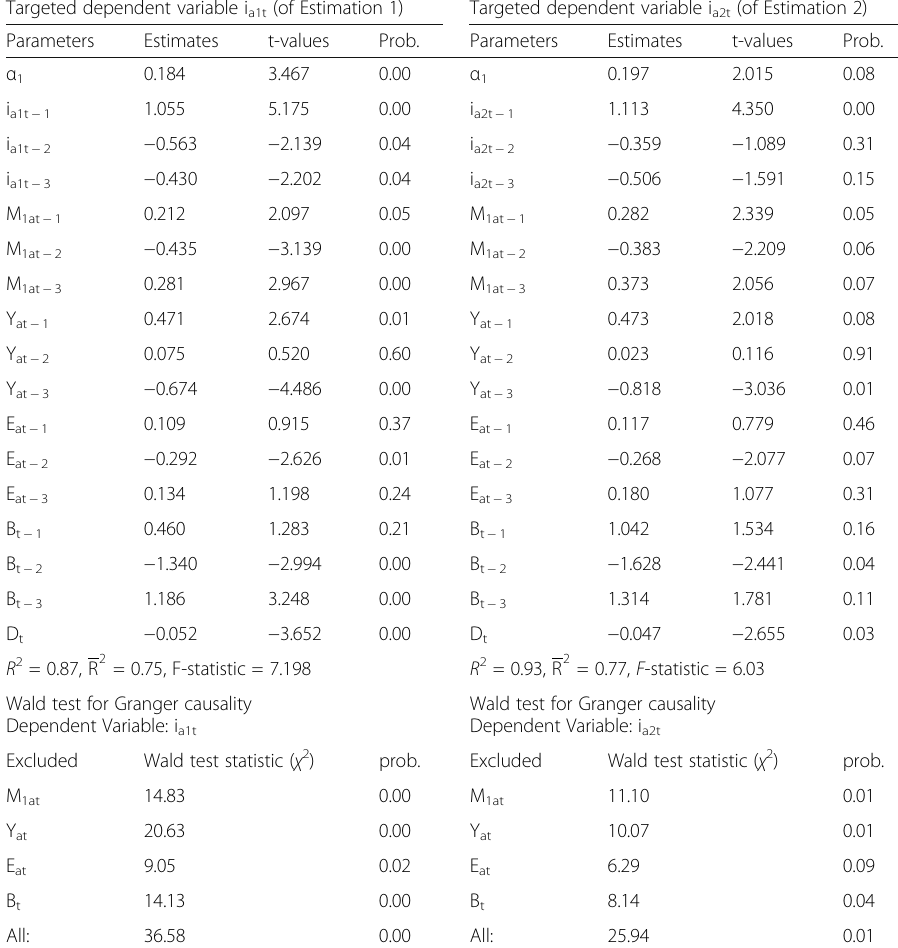
Table 3 Dynamics of annual interest rates (M1 money growth is used) Targeted dependent variable i a1t (of Estimation 1) Targeted dependent variable i a2t (of Estimation